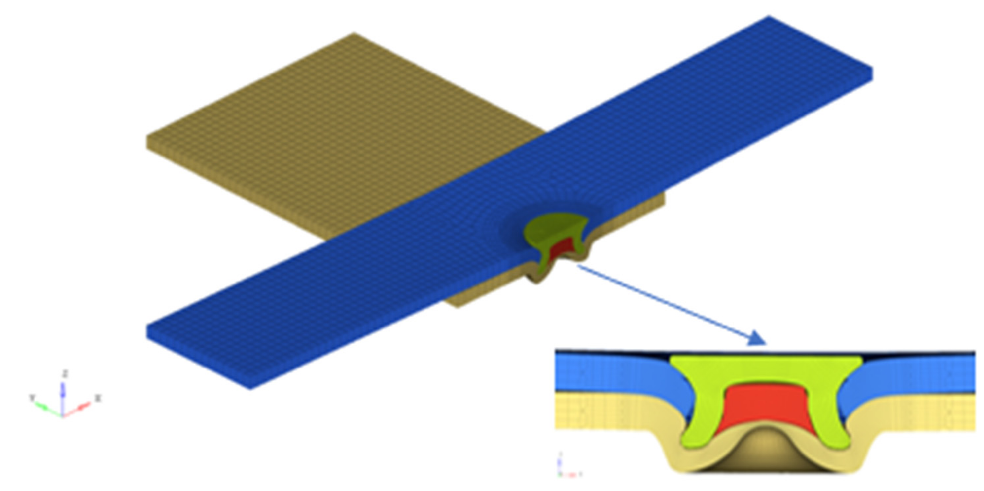
Figure 7. Overview of FE models and a detail SPR joint for the cross-shaped specimen.